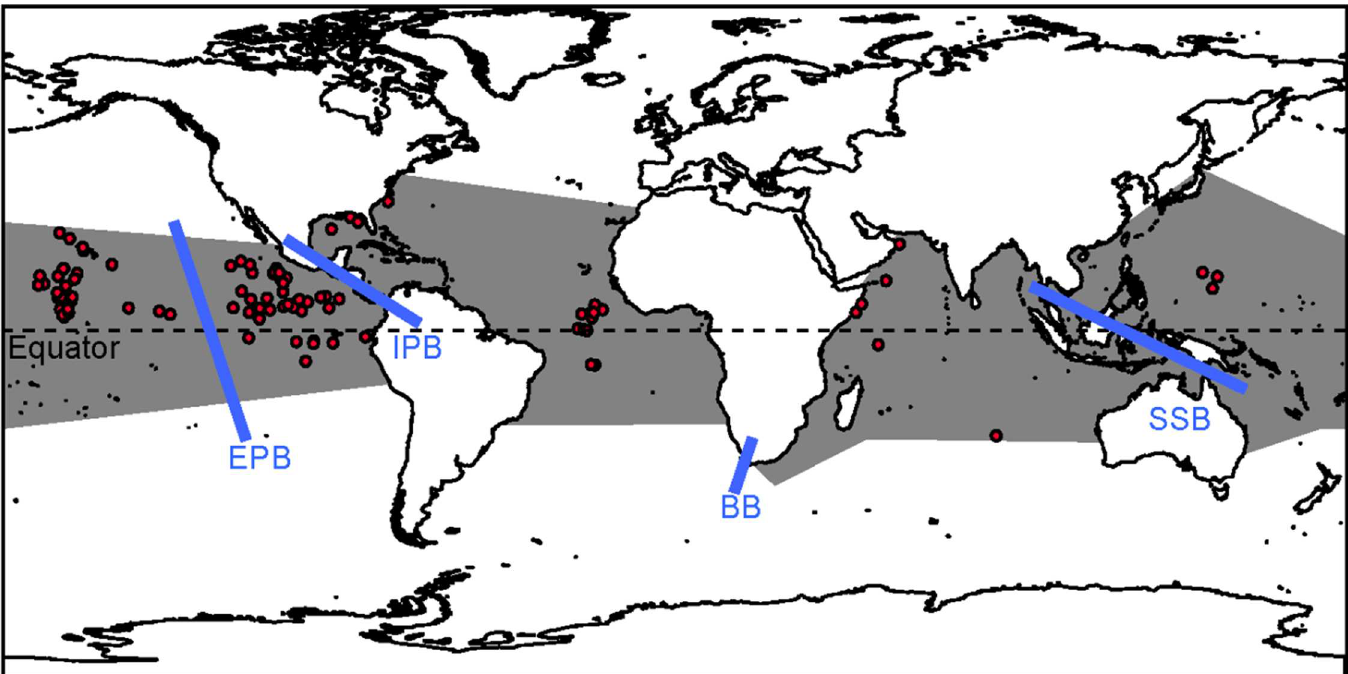
Fig 1. Collection localities for Exocoetus volitans specimens used in this study. In total, 266 individuals were collectedfrom 97 localities (red circles) . Grey polygonsapproximate the species’ distribution, based on Parin and Shakhovskoy [6]. Previously-describedmarine barriers tested are indicatedby blue bars (EPB = Eastern Pacific Barrier; IPB = Isthmus of Panama Barrier; BB = BenguelaBarrier; SSB = Sunda Shelf Barrier). This figure was generated using ArcGIS, version 9.3.1 (ESRI, Redlands,CA,